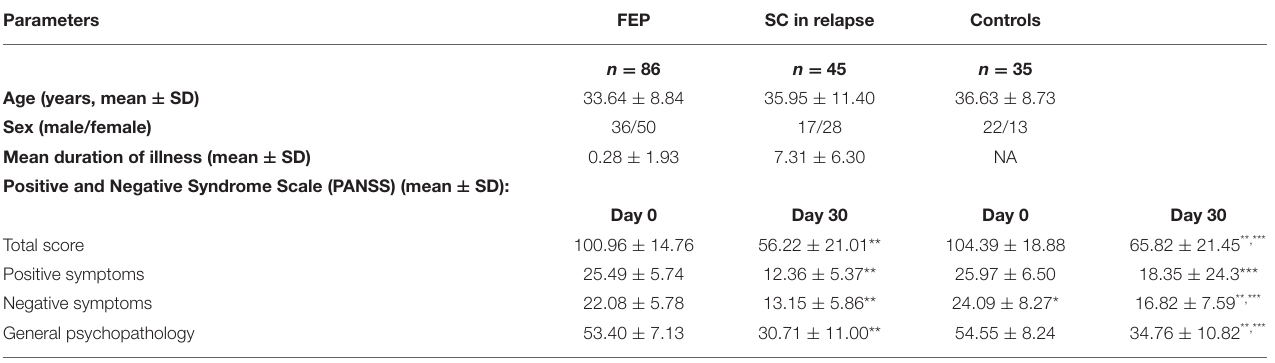
TABLE 1 | Demographic and clinical characteristics of the sample. Parameters